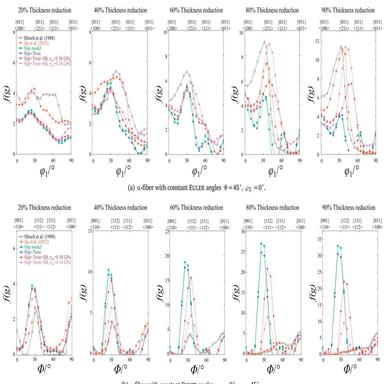
Texture evolution of cold rolled α-brass at different thickness reduction levels in fiber representation. Figure adopted from with permission from Elsevier.